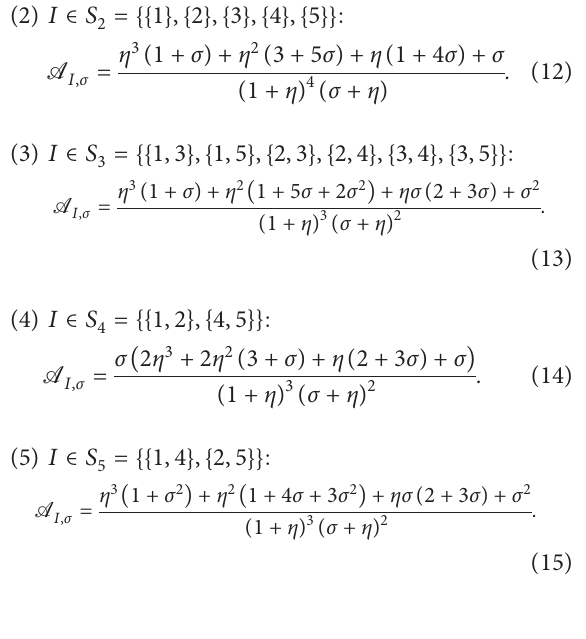
Figure 2: Tie sets for the bridge